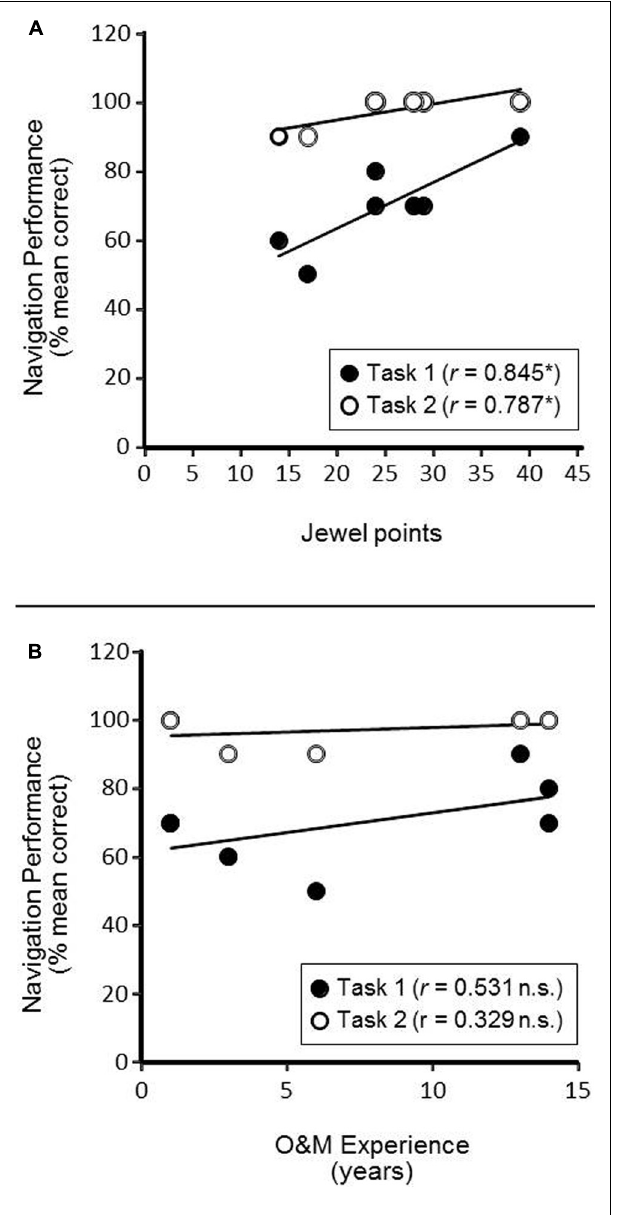
FIGURE 3 | Correlations between NavigationTask Performance and Factors of Interest. (A) Associating navigation task performance and game play success (number of jewel points) reveals a positive and significant relationship. * p < 0.05 (B) Associating navigation performance and O&M experience (measured in years) did not reveal a significant correlation. n.s. = not